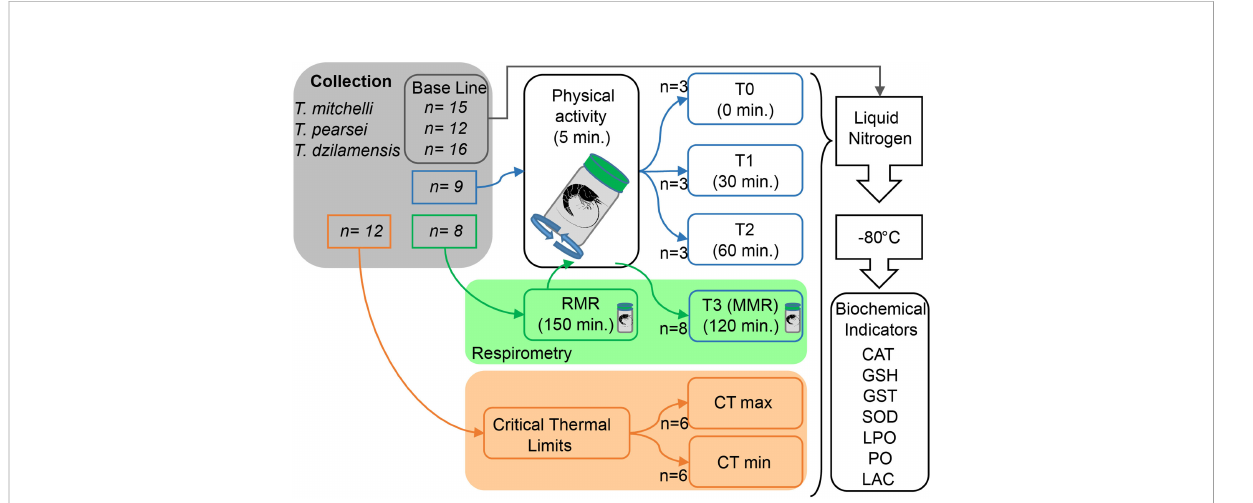
FIGURE 1 Flow chart showing the methods used for the metabolic, biochemical and thermal characterization of T. mitchelli , T. pearsei and T. dzilamensis . The number outside each box indicates the number of individuals (n) used for each experimental test or control. Baseline (BL) individuals are those that did not undergo an experimental treatment. The evaluation of biochemical indicators (BI) includes indicators of the antioxidant system: catalase (CAT), total glutathione (GSH), glutathione S-transferase (GST), and superoxide dismutase (SOD); indicators of oxidative damage: lipid peroxidation (LPO) and protein carbonylation (PO) and lactate (LAC) accumulation by anaerobic metabolism. CT max and CT min are critical thermal maxima and minima,